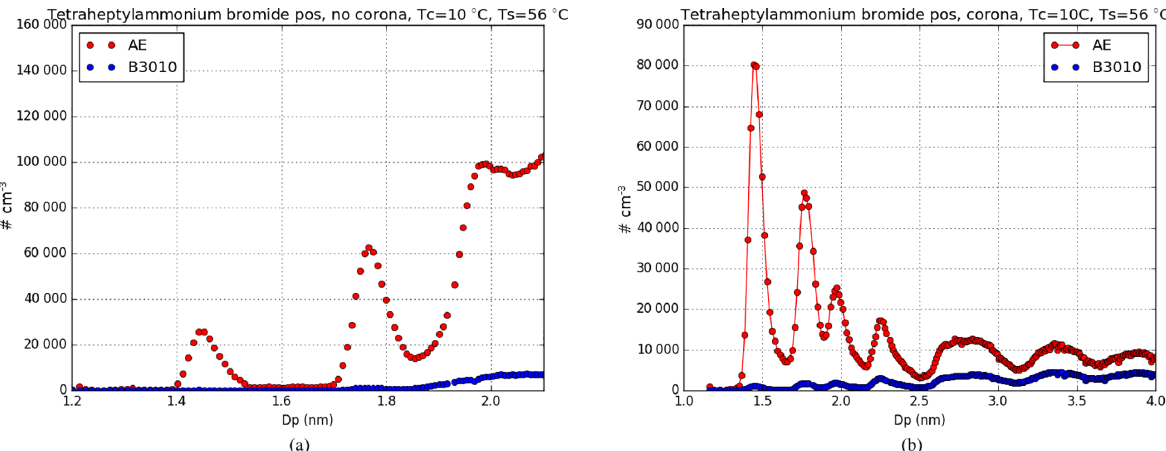
Figure 3. Effect of the corona discharge. When the corona discharge is off (a) , the signal of the aerosol electrometer (AE) rises sharply above